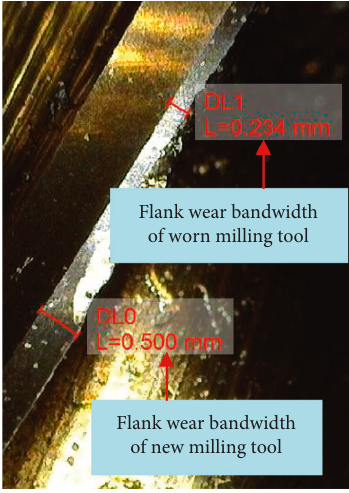
Figure 4: Measurement method of the tool flank